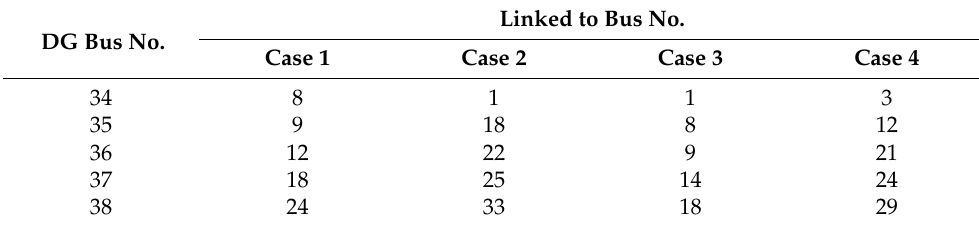
Table 1. Four cases for DG placement in IEEE 33-bus distribution. DG Bus No.